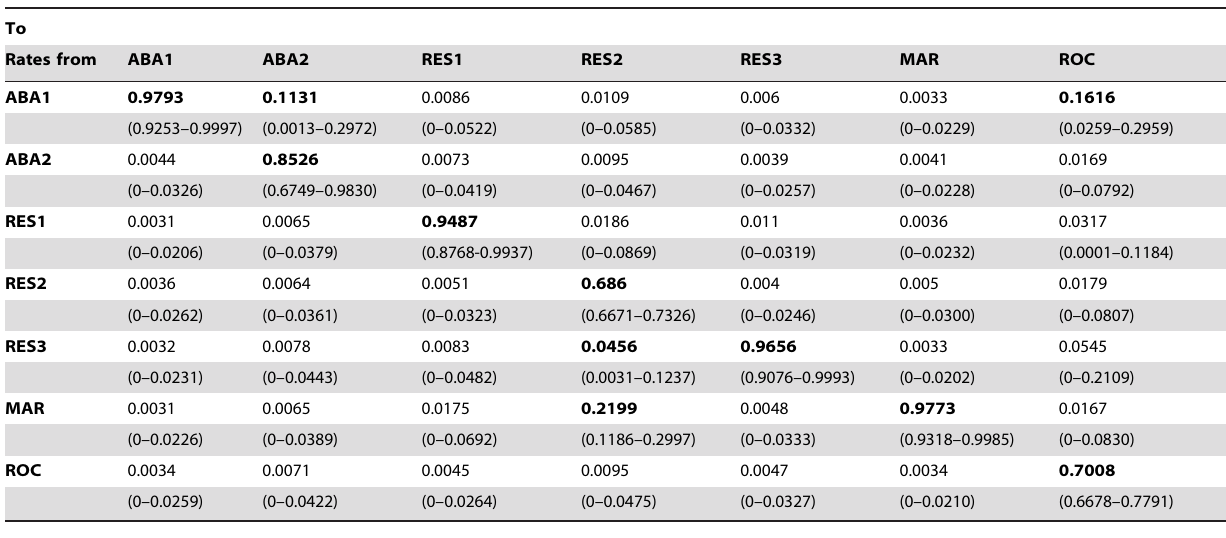
Table 2. Means and 95% confidence intervals of the posterior distributions of m , the migration rate into each population for the three replicates run on